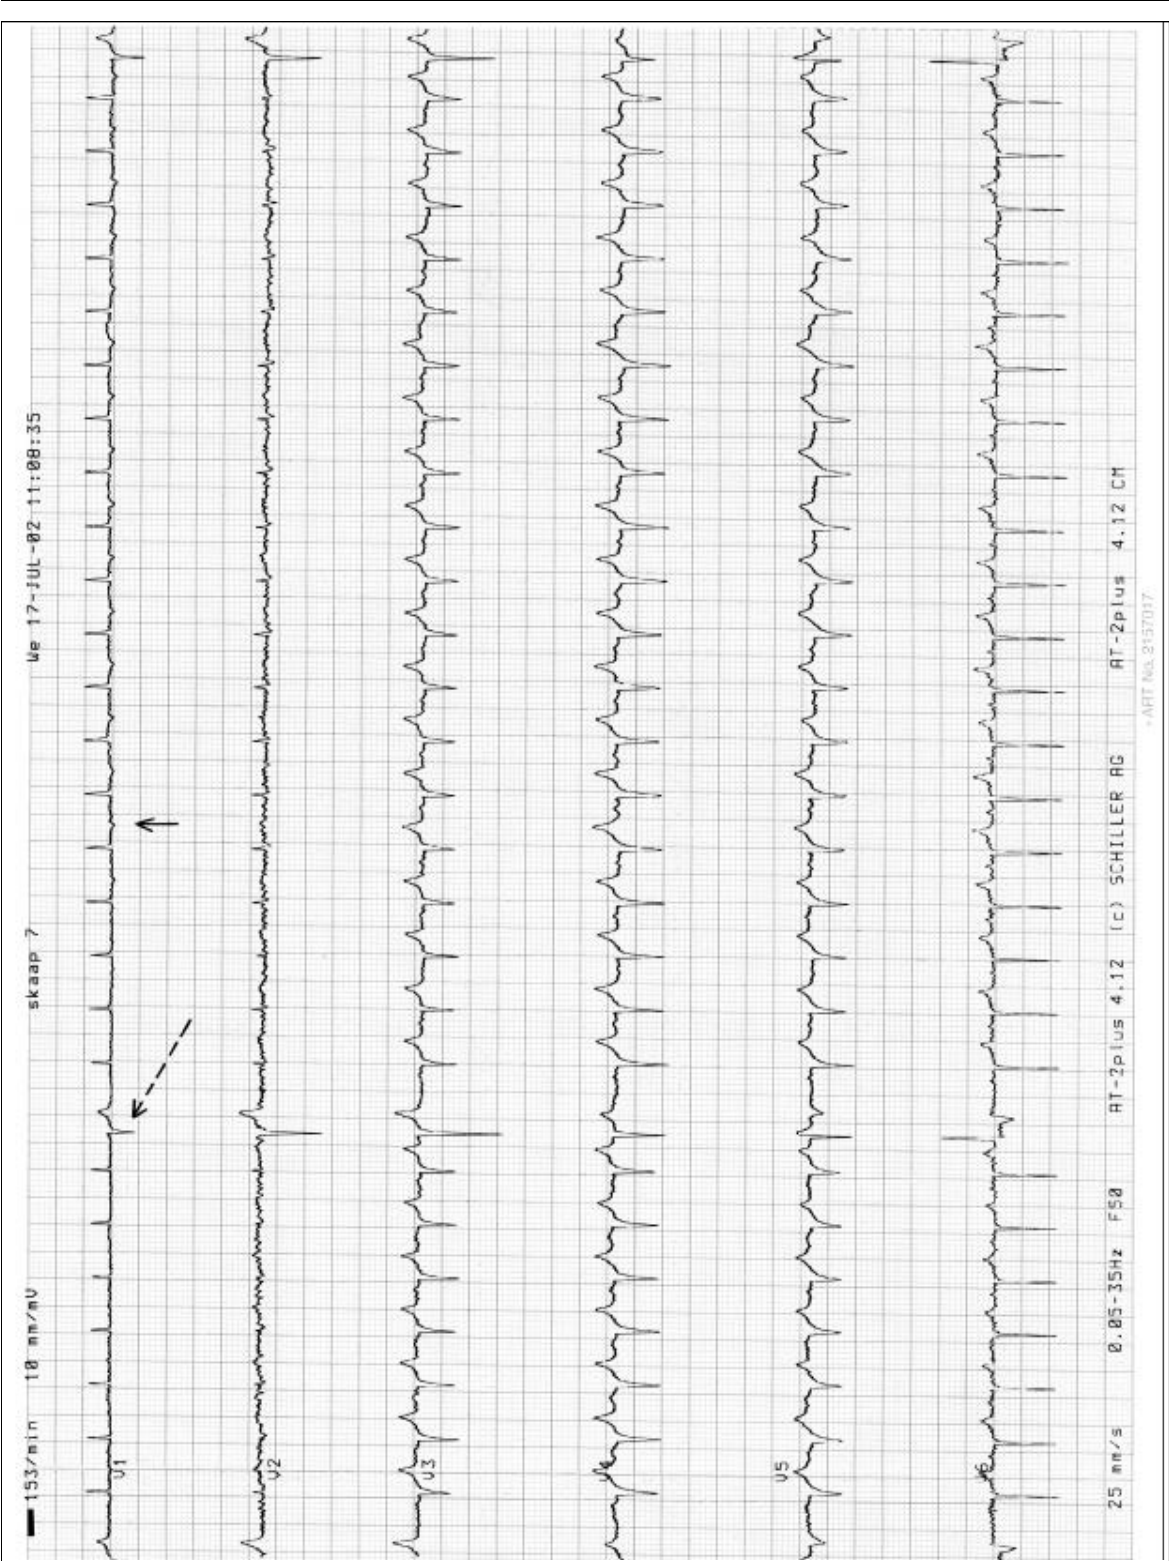
FIG. 2 Example 2—cardiac memory, demonstrated in lead